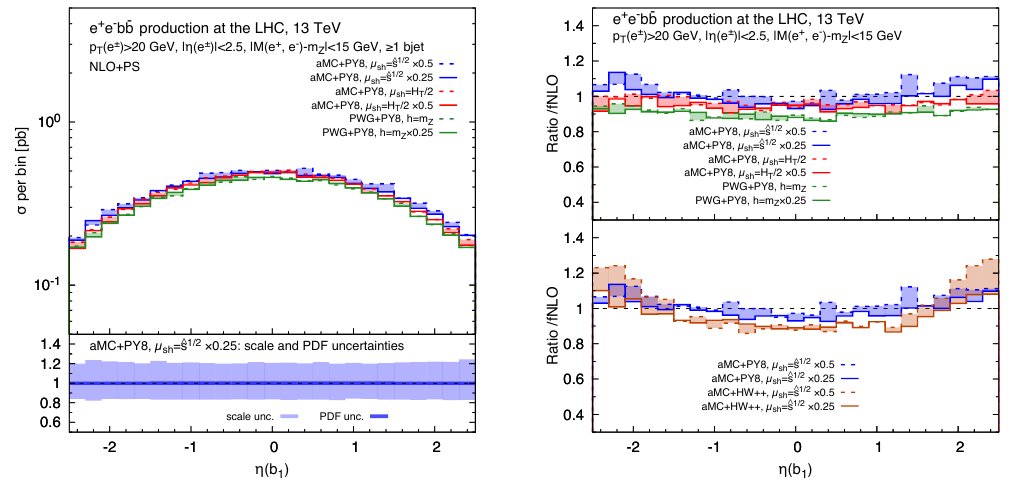
Figure 29 . Pseudo-rapidity distribution of the hardest b jet.